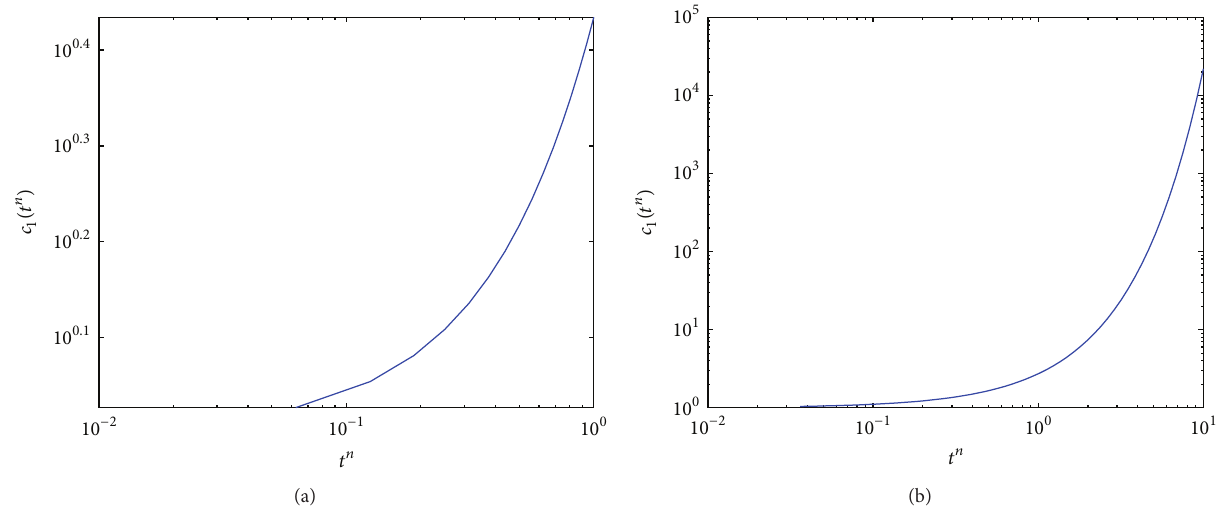
Figure 1: Short time and long time behavior of the solution ((a) 𝑇 = 1 , (b) 𝑇 = 10 ).